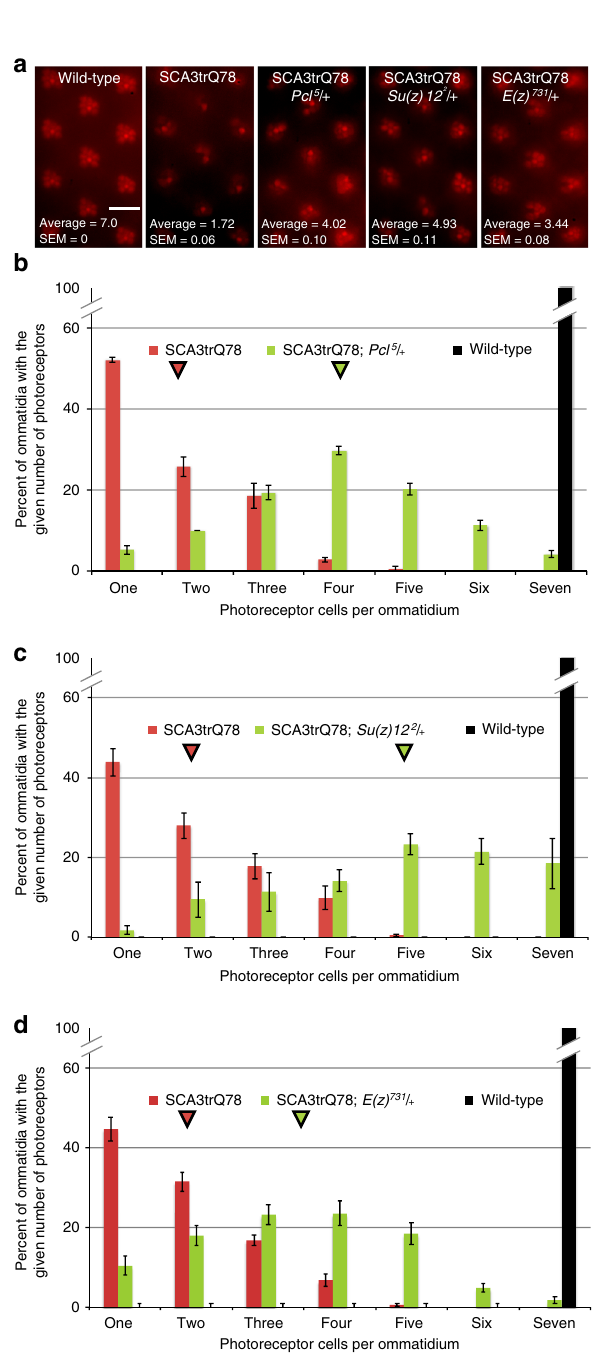
genes, GO Terms, Kegg Pathways, and InterPro motifs among genes that are downregulated with age to those that are upregulated in the E(z) mutant. This identi fi ed four categories: GO:0005887 ∼ integral component of the plasma membrane, dme:01100:Metabolic pathways, IPR002068:Alpha crystallin/ Hsp20 domain, and IPR001436:Alpha crystallin/Heat shock protein. Intriguingly, sHSPs were common to both sets of NATURE COMMUNICATIONS| (2018) 9:4188 |DOI: